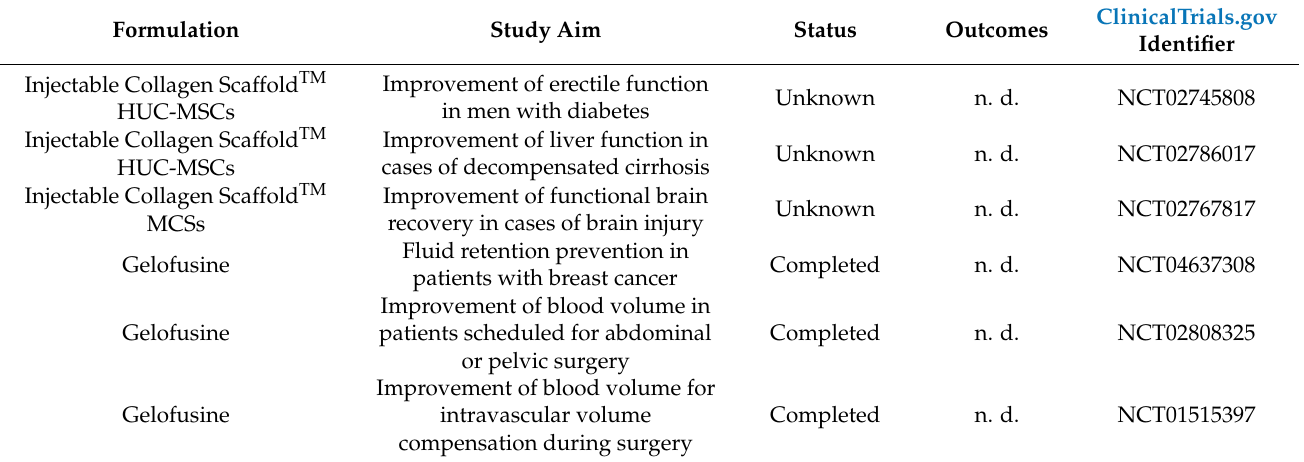
Table 4. New applications of collagen based injectable